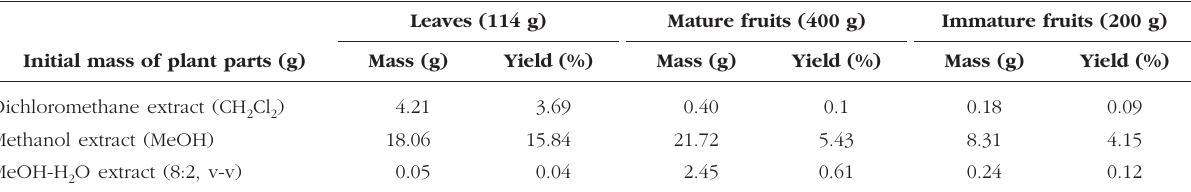
Table I. – Mass and yields of different plant part extracts of Solanum nigrum var. villosum after 24 hours extraction with increasing polarity